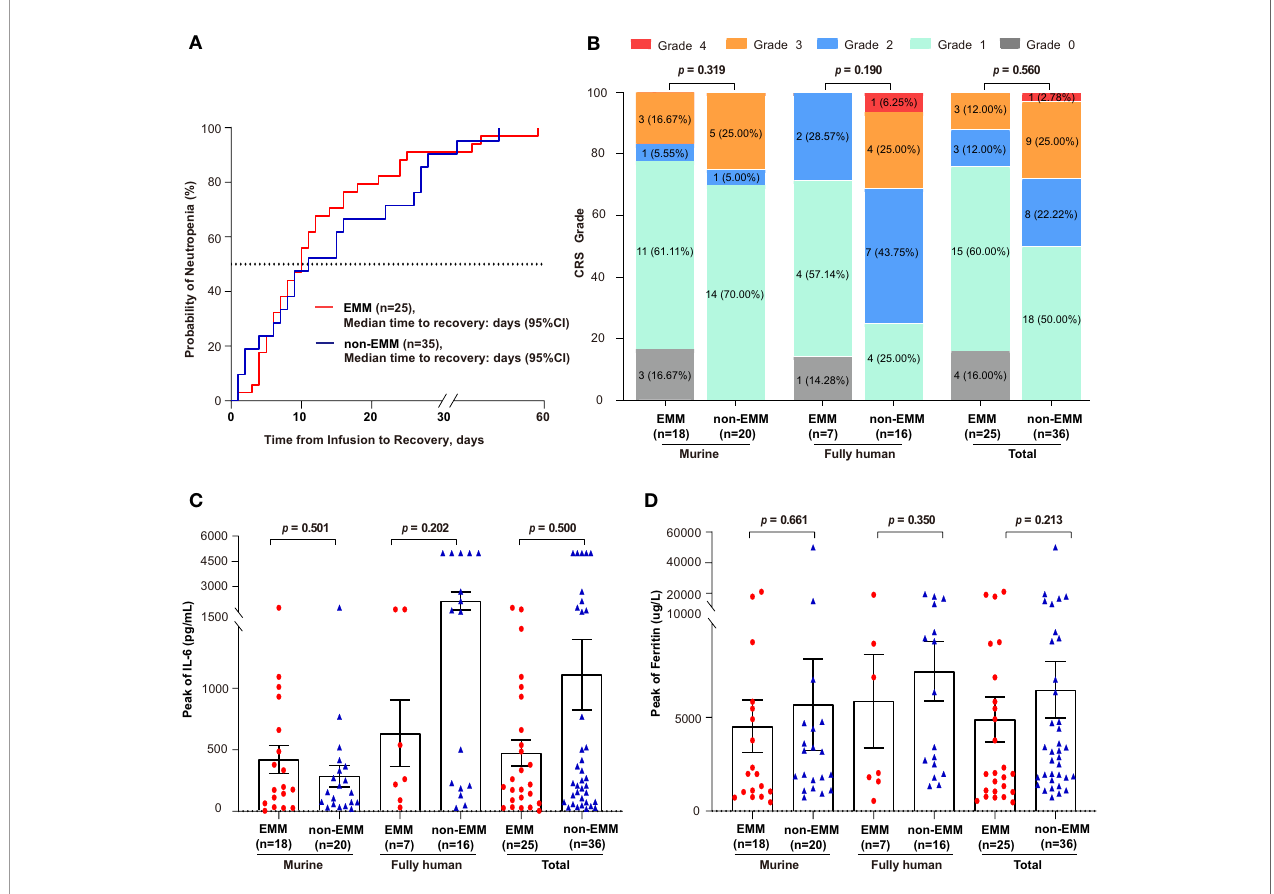
FIGURE 2 | Comparison of time to recovery of neutrophil, cytokine release syndrome (CRS), and in fl ammatory factors between EMM patients and non-EMM patients receiving anti-BCMA CAR-T cell therapy in two clinical trials conducted in our center (A) Time to the recovery of patients with grade 3/4 neutropenia is shown. One non-EMM patient was excluded because the neutrophil count had not recovered until death (OS = 20 days). Time to recovery, which is de fi ned as absolute neutrophil count ≥ 1000 cells/ m L from infusion till the fi rst time of recovery. (B – D) Comparison of the CRS grade, the peak levels of IL-6 and